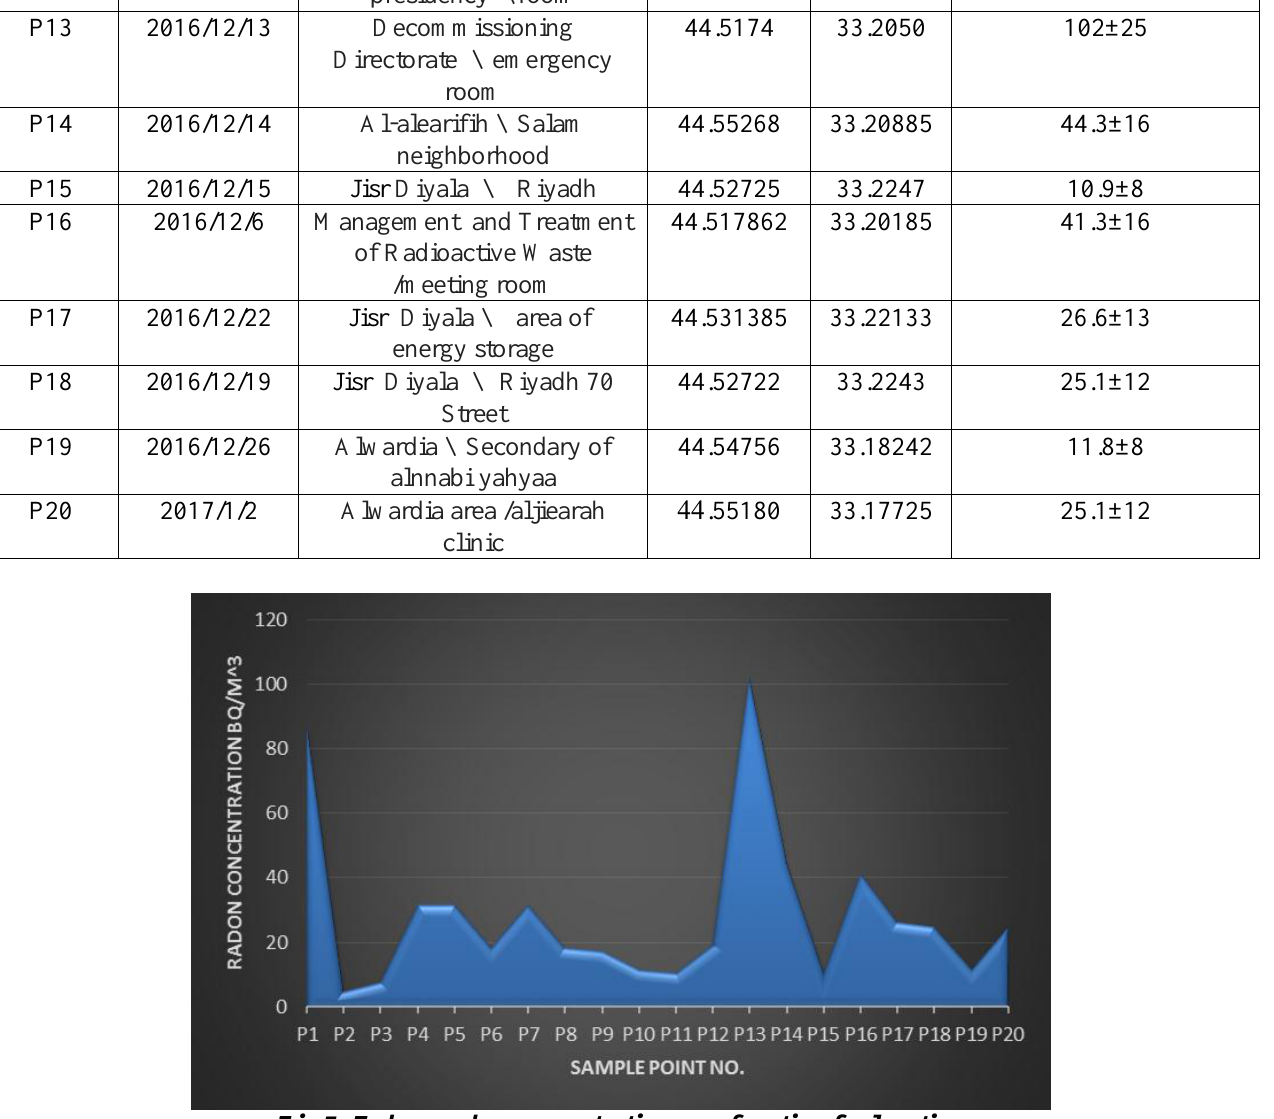
adon concentration as a function for location.rFig.5: